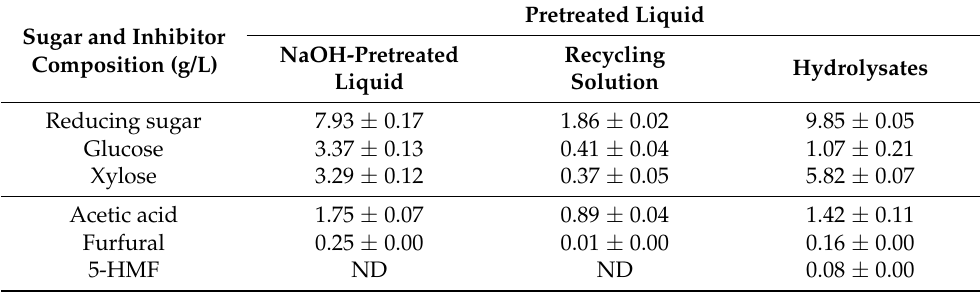
Table 4. Sugar and composition of pretreated liquid from the different pretreatment